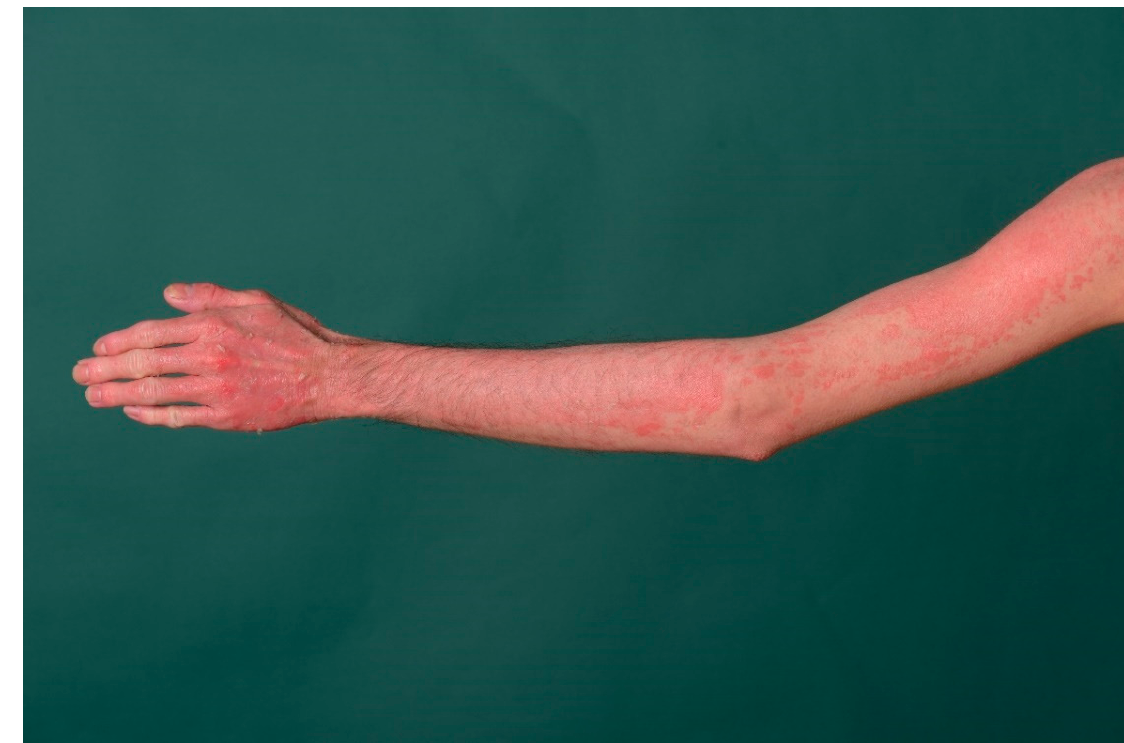
Figure 12. Peeling skin disease. Diffuse erythema with superficial skin detachment is evident from birth and persists throughout life with seasonal variation.